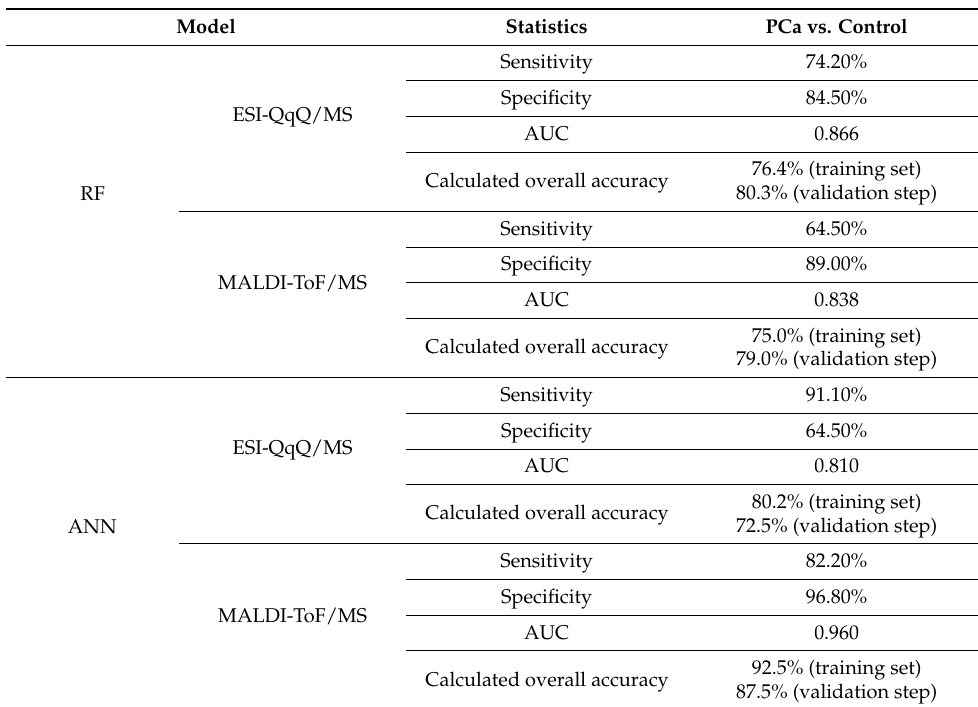
Figure 7. ANN analysis—variable importance plot referring to the 14 most relevant features selected from the ESI-QqQ/MS ( A ) and MALDI-ToF/MS ( B ) analysis; ROC curves corresponding to the plotted probabilities calculated from the developed model for the ESI-QqQ/MS ( C ) and MALDI- ToF/MS ( D ) data, when PCa is labeled as the state variable. Table 2. Information regarding the performance of the developed machine learning models (RF— random forest, ANN—artificial neural network, AUC—area under the